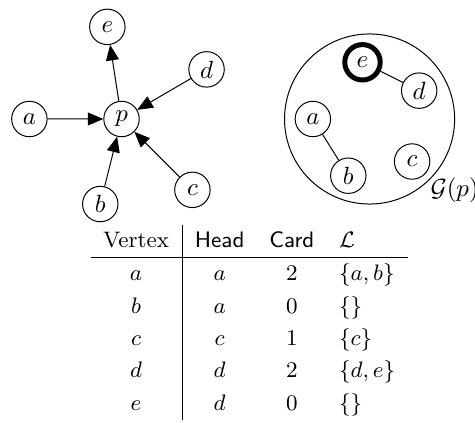
Figure 6 A vertex p with five neighbors (left), its local subgraph G ( p ) (center) and the corresponding state of the Union-Find data-structure (right). Oriented arcs indicate the predecessors in T ∗ . In G ( p ), the vertex corresponding to e = Pred ( p ) is indicated by a thick line. Local vertices a and b have been connected with a horizontal link; consequently, the lists of a and b have been merged in a single list, so that L ( a ) = { a, b } , L ( b ) = ∅ , Card ( a ) = 2, Card ( b ) = 0 and Head ( a ) = Head ( b ) = a . The local vertex d has been connected to e = Pred ( p ) with a vertical link; consequently, the lists of d and e have been merged in a single list, so that L ( d ) = { d, e } , L ( e ) = ∅ , Card ( d ) = 2, Card ( e ) = 0 and Head ( d ) = Head ( e ) = d